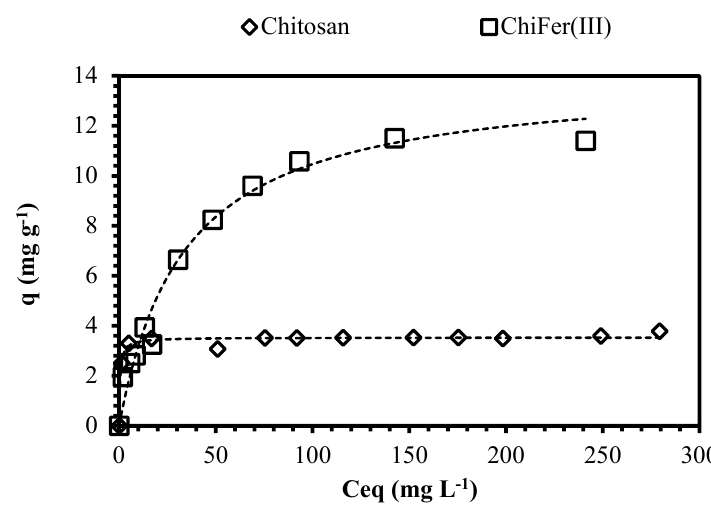
Figure 5. Isotherm plots for neodymium removal. (Solid line: Langmuir model; T: 20 °C; sorbent dosage, SD: 1 g · L − 1 ; agitation speed: 150 rpm; contact time: 72 h; pH: 4; C 0 : 5–400 mg · L − 1 ).